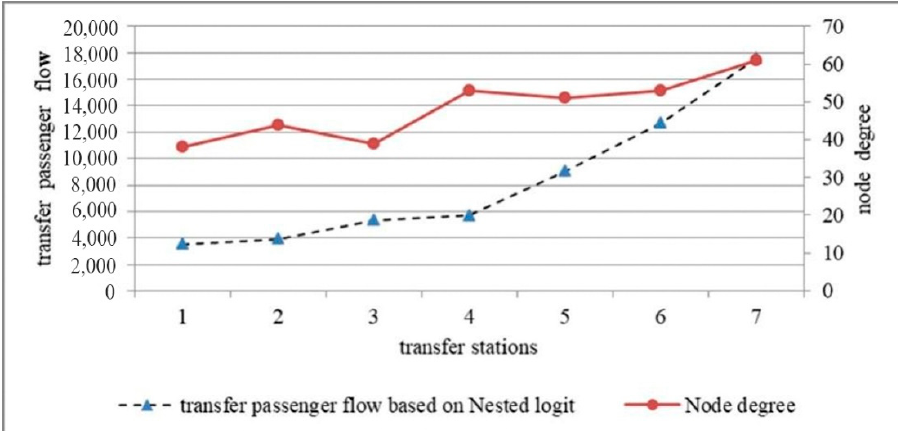
Figure 6. The relationship between transfer passenger flow and node degree.